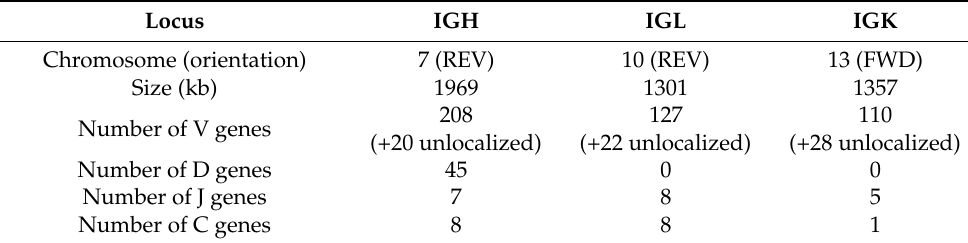
Table 1. Results obtained from the IG loci of Macaca mulatta (rhesus monkey).